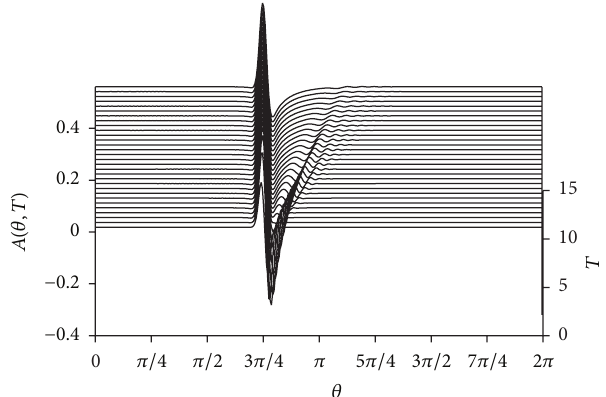
Figure 2: Solitary waves generated by topography in the presence of dissipation ( 𝜆 = 0.3 , 𝛼 = 2.5